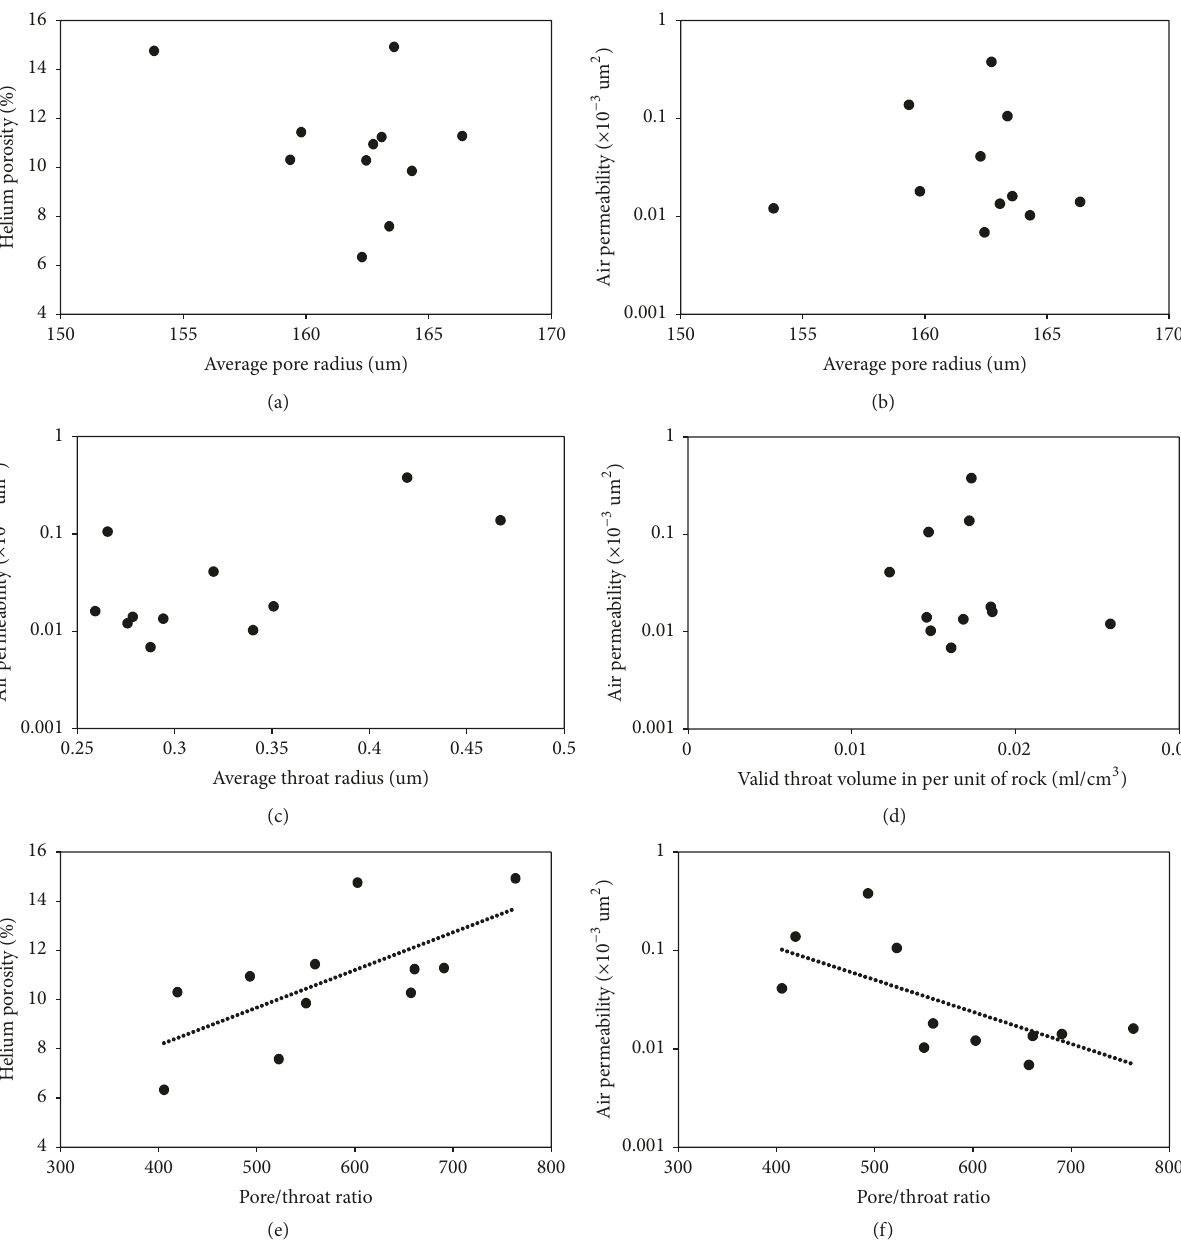
Figure 7: The correlation of pore-throat parameters and porosity and permeability of the tight clastic rock samples from Upper Triassic Chang 7 Member, Odors